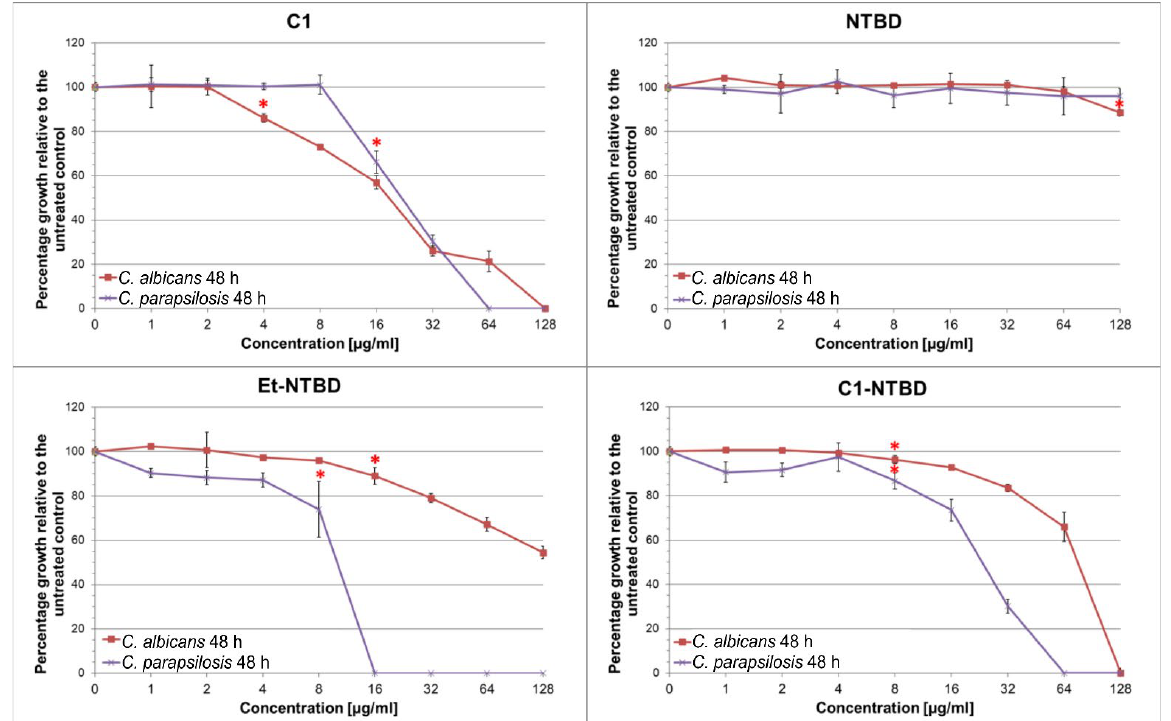
Figure 2. Effect of thiadiazoles on the growth of C. albicans NCPF 3153 and C. parapsilosis ATCC 22019. The percentage growth of thiadiazole-treated cells measured as OD600 relative to the control was calculated from the following equation: (OD600 of treated sample)/(OD600 of untreated sample) × 100; * represents the lowest concentration at which a statistically significant decrease in OD was noted, compared with the control (one-way ANOVA, Tukey’s post-hoc